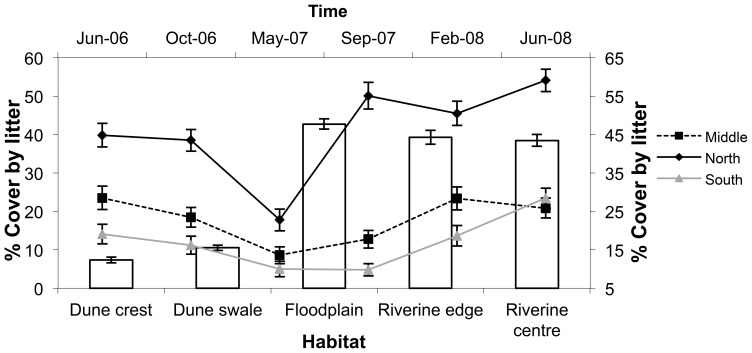
Percentage leaf litter cover (mean ± s.e.) in five habitats (bars - left axis) and in the northern, middle and southern sites (lines - right axis) from June 2006 to May 2008, along the Field River, Simpson Desert, Queensland.